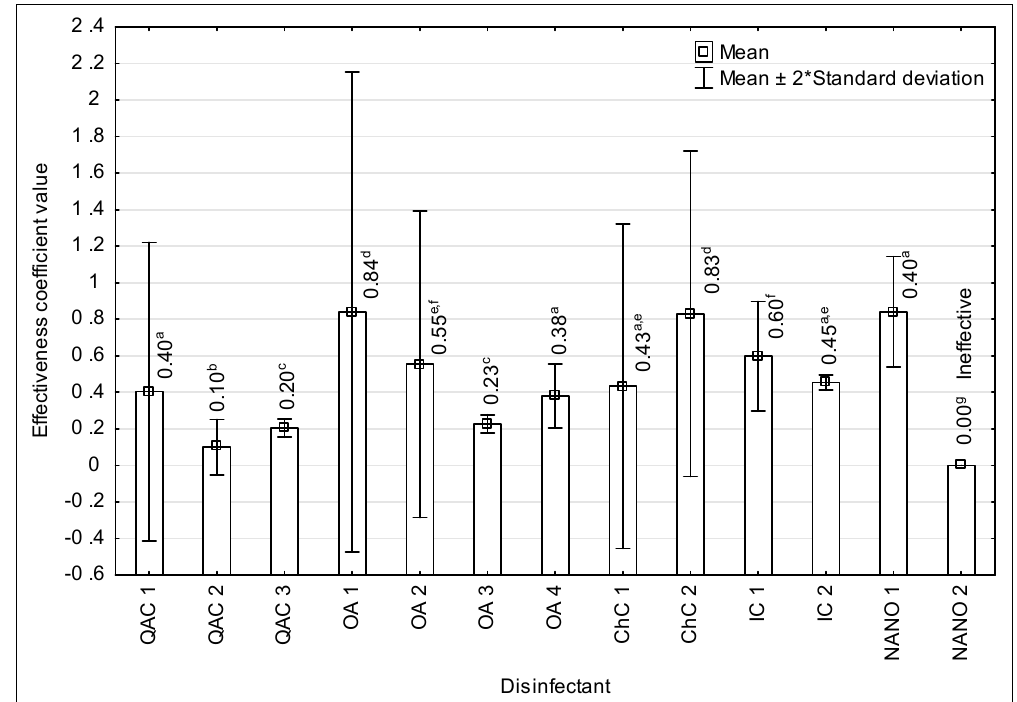
Figure 2. Values of efficacy coefficients for the tested disinfectants, including their belonging to distinguished groups (QAC—quaternary ammonium compounds, OA—oxidizing agents, ChC—chlorine compounds, IC—iodine compounds, NANO—nanoparticles); a–g—variables with different letters are statistically different ( p ≤ 0.05)